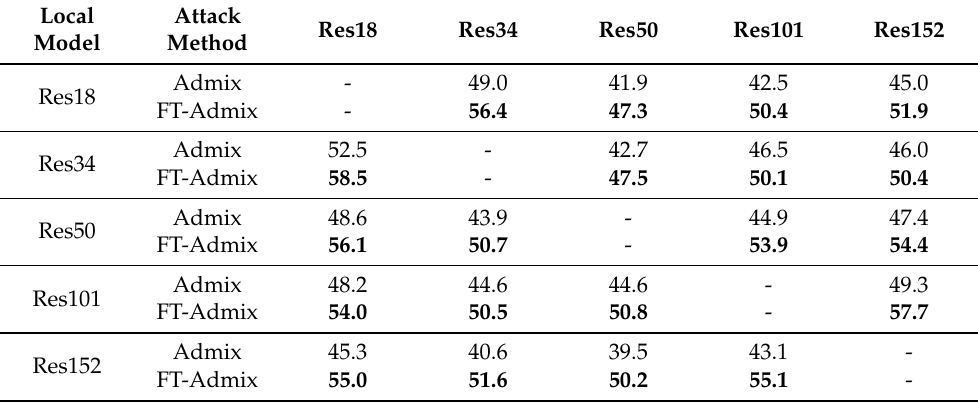
Table 9. The black-box ASRs of Admix and FT-Admix on Cifar10. The first column is the local model, and the first row is the target model. The values in the table are the ASRs (%) on the target models using the adversarial examples generated with the local models. The higher ASRs are shown in